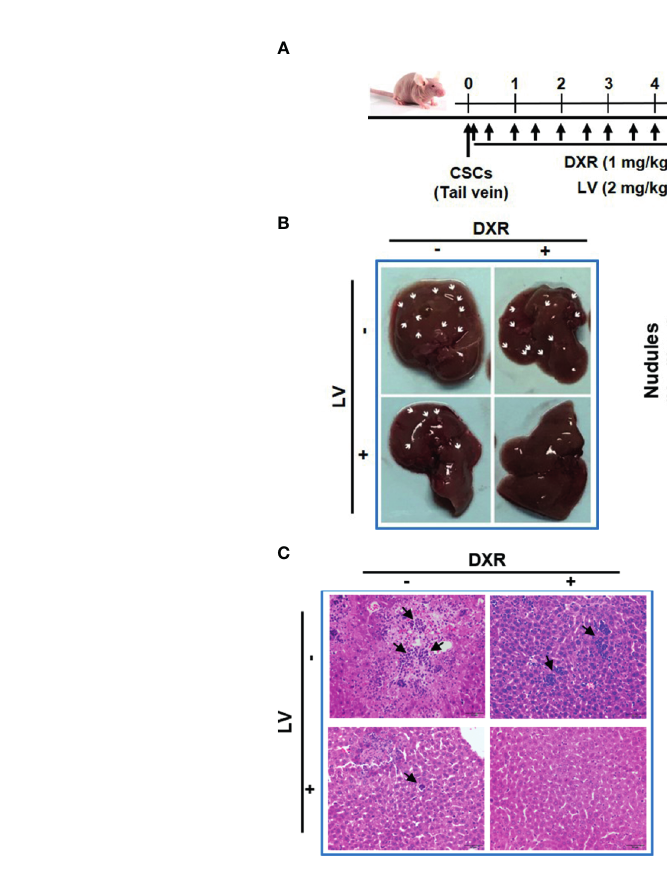
FIGURE 6 | Lovastatin inhibits metastasis of TNBC CSCs in vivo . Schematic of the mouse model of tumor metastasis (A) . Representative images of the livers from each group of mice. Arrows indicate the tumor nodules on the liver. Right, quanti fi cations of the tumor nodules on liver surface (B) . Representative H&E-stained histopathological images showing reduced colonization of tumor cells in the liver by combination treatment with lovastatin and DXR. Arrows indicate the metastatic tumor cells in the liver. Right, quanti fi cations of the metastatic tumor cells on liver surface. Original magni fi cation: 40× (C) . # CI < 1.0, showing synergism between the two drugs. LV, lovastatin; DXR, doxorubicin; iv, intravenous injection; ig, intragastric